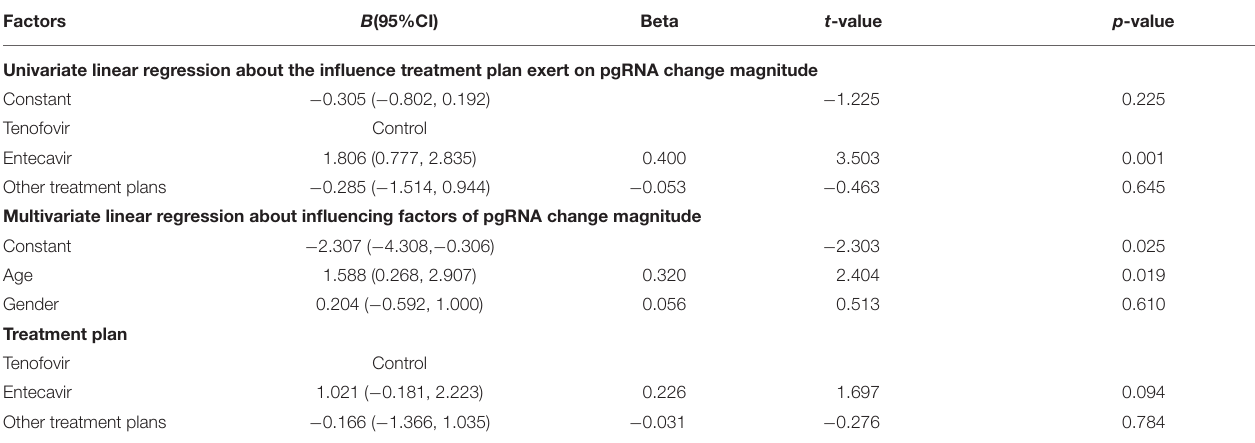
TABLE 4 | The results of linear regression about pgRNA change magnitude. Factors B (95%CI) Beta t -value p -value